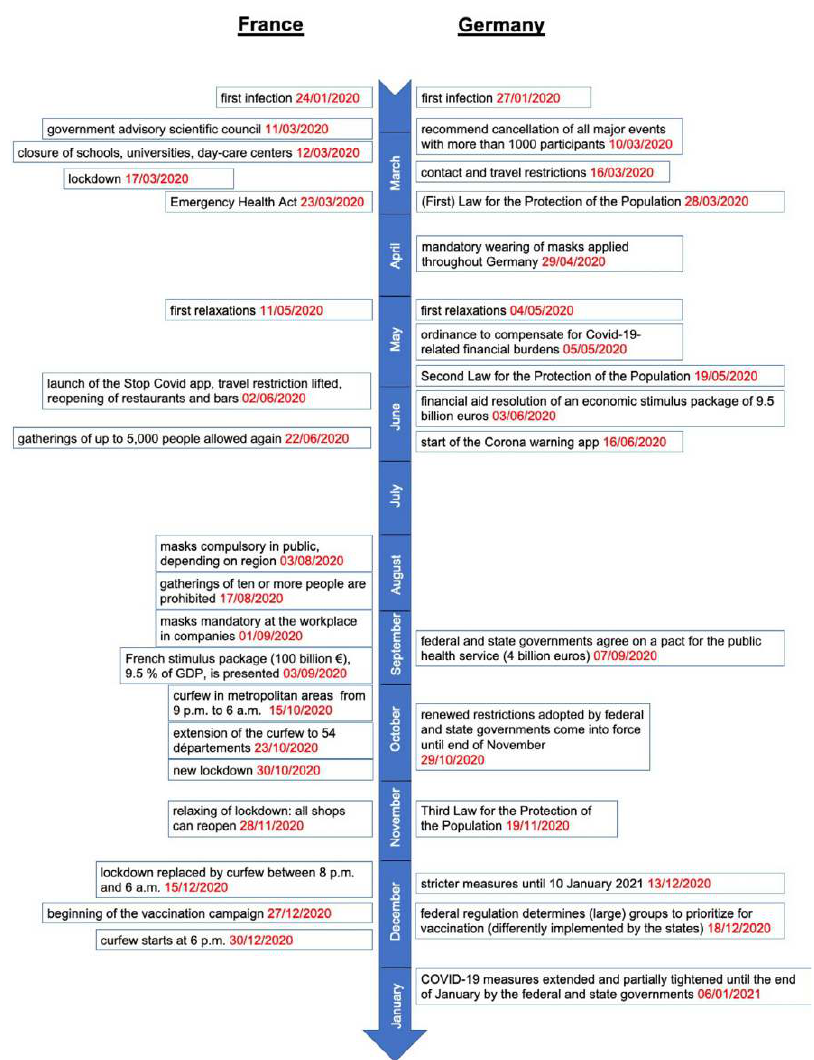
Figure 1: Timeline of COVID-19 related measures